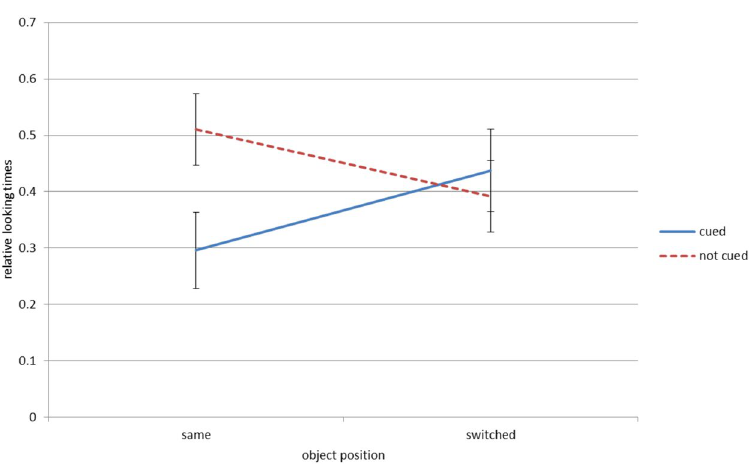
Figure 5. Reversed-contrast condition: graphs of the mean relative looking times for the previously cued and not-cued objects in trials with objects staying at the same position or switching positions. Error bars represent 95% confidence